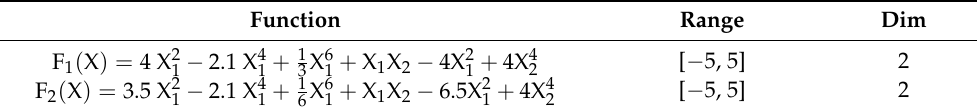
Table 2. Fixed dimension benchmark functions.